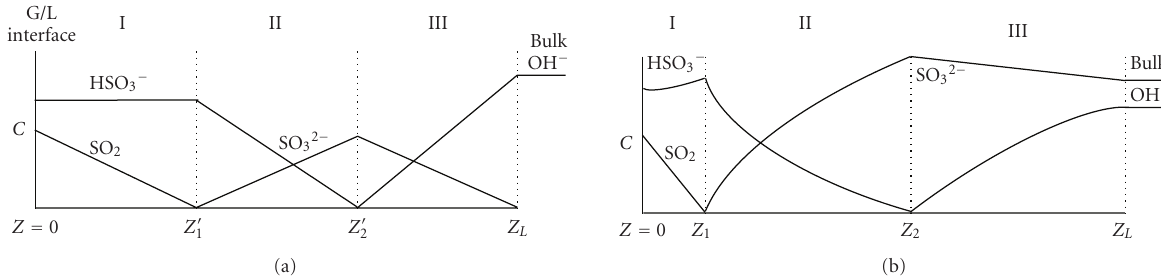
Figure 1: Concentration profile for SO 2 / Mg(OH)